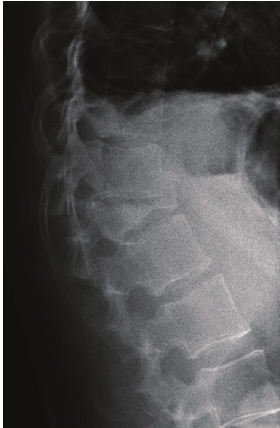
Figure 1: X-ray showing a burst fracture of T12.